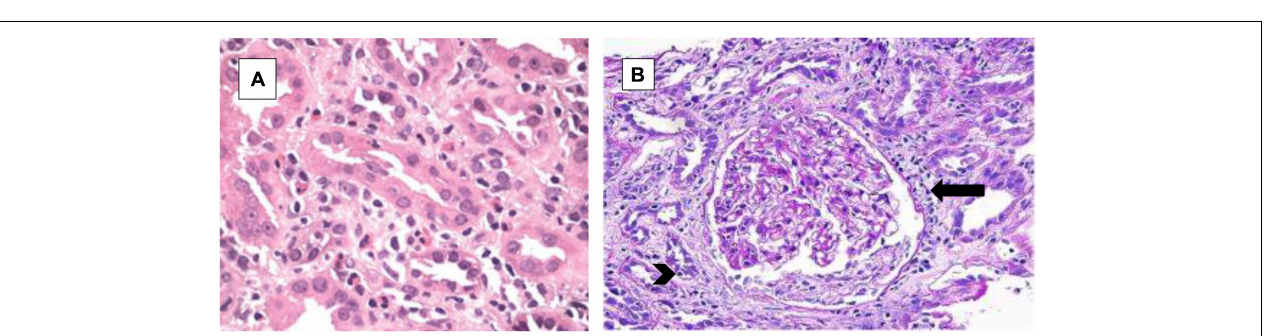
FIGURE 2 | Hematoxylin and eosin (H&E) stain. (A) Low power- diffuse cellular infiltrate within the interstitium with inflammatory cells including eosinophils and lymphocytes. (B) High power- the tissue sample shows the presence of inflammatory cell infiltrate within the tubular wall (arrowhead) and numerous eosinophils in the interstitium